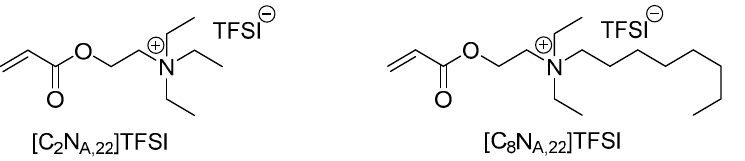
Figure 1. Structures of the monomeric ionic liquids, which were selected to build up a polymer electrolyte membrane for lithium ion batteries.